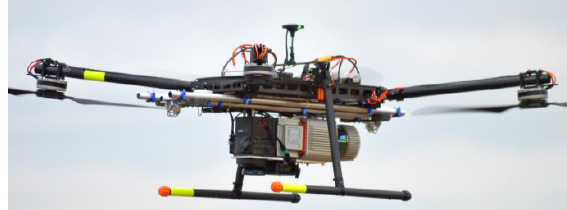
Figure 5: AeroSpector carrying a Riegl VUX Sys Lidar and a PhaseOne iXM-RS 150 Camera for more than 40' (Business Geomatics